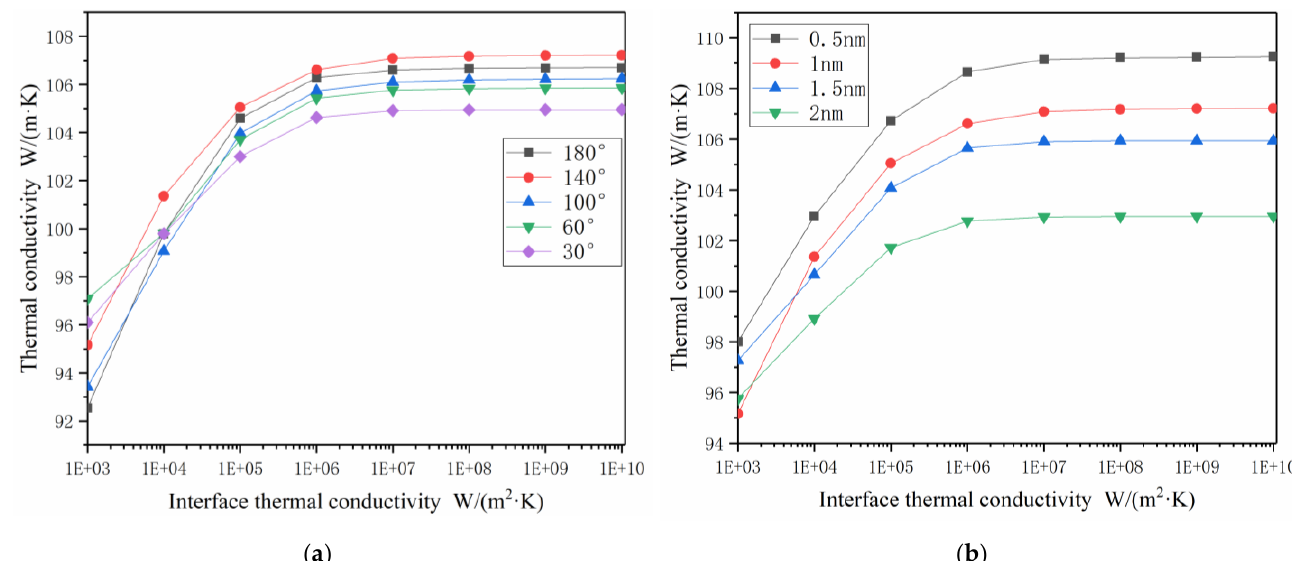
Figure 7. Impact of different influencing factors on k c : ( a ) The k c values of CNTs/Co models with different degrees of bending CNTs; ( b ) The k c values of CNTs/Co models with different radii of CNTs.